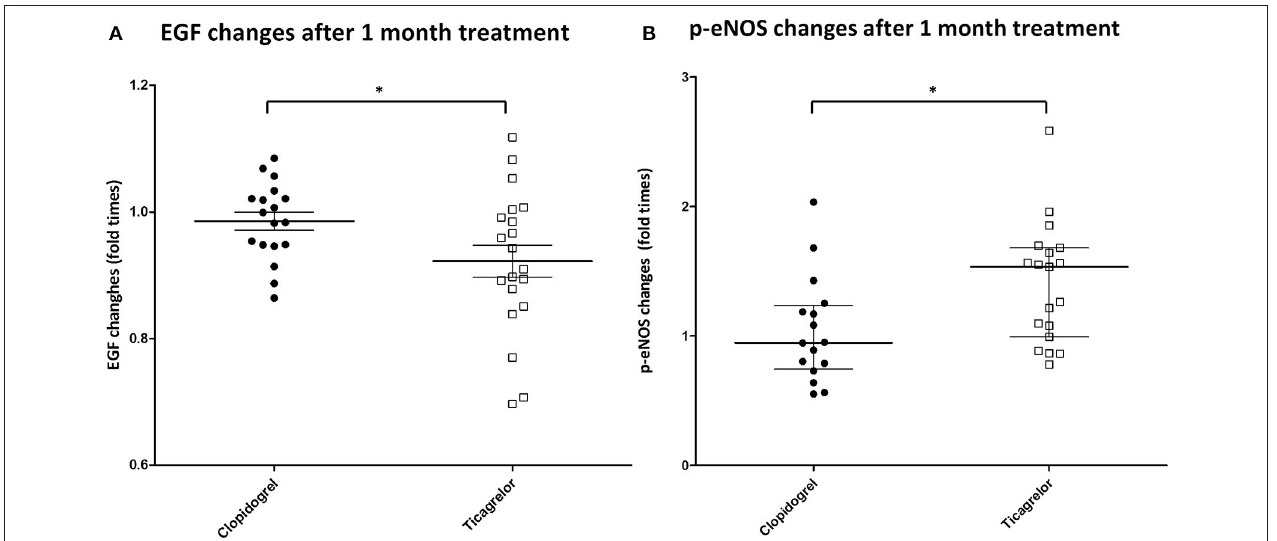
FIGURE 4 | (A) Changes in EGF levels in the serum of patients (on the y-axis is shown the ratio between EGF levels after 1 month of treatment and at baseline). Black circle: patient randomized to clopidogrel. White square: patient randomized to ticagrelor. * P < 0.05. (B) Changes in p-eNOS levels in HUVEC treated with patient’s sera (on the y-axis is shown the ratio between p-eNOS levels in HUVEC treated with patient’s sera after 1 month of treatment and at baseline). Black circle: patient randomized to clopidogrel. White square: patient randomized to ticagrelor. * P < 0.05.